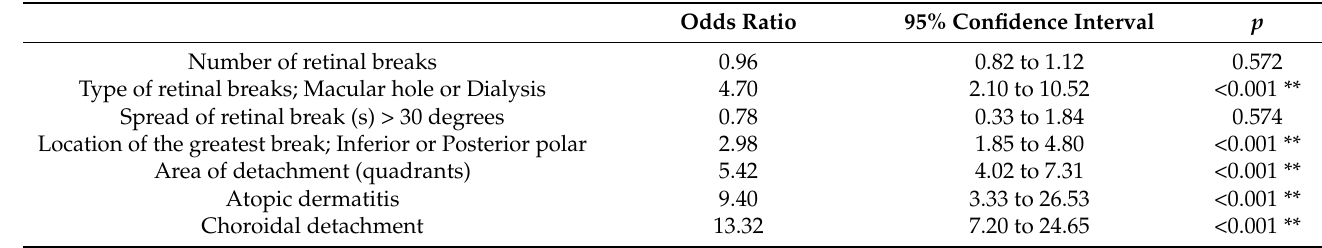
Table 2. Risk factors for exhibiting proliferative vitreoretinopathy grade C at baseline.